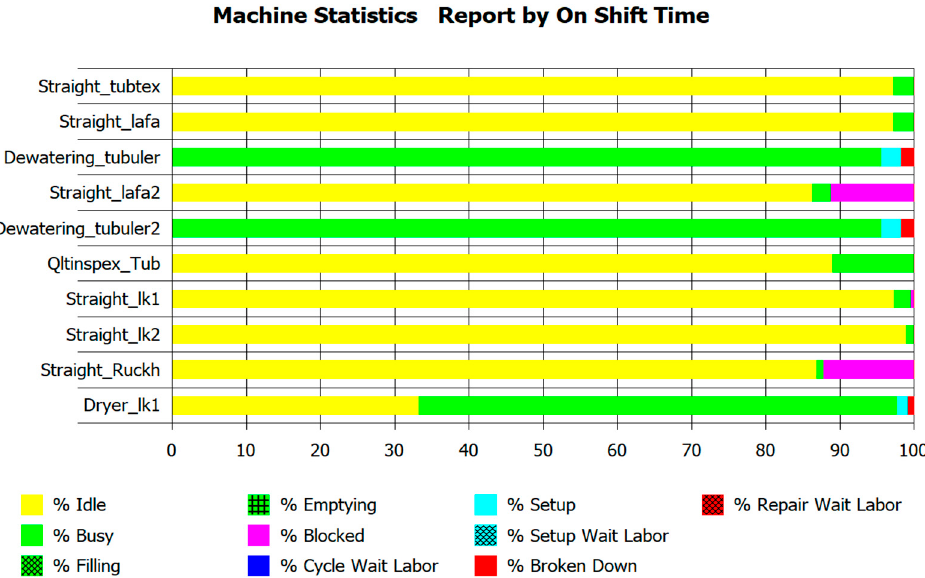
Figure 6. Machine statistics for set-up, blocked, and breakdown time.